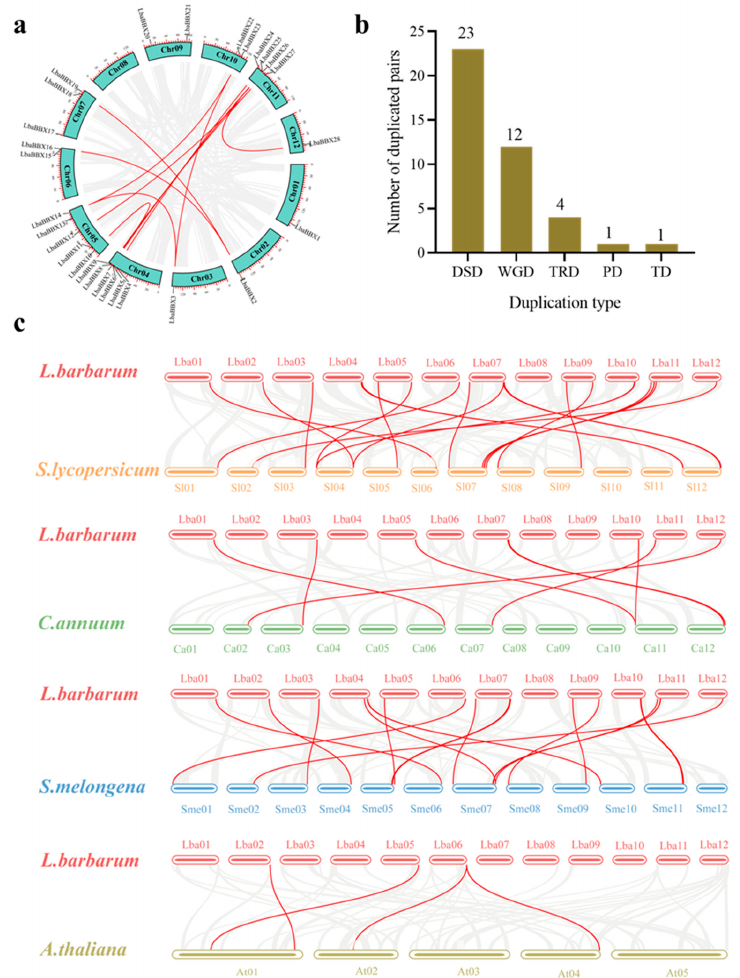
Figure 3. Chromosomal location and duplicated genes among LbaBBX genes. ( a ) Intraspecific col- linearity analysis. A total of 28 LbaBBX genes were mapped onto the chromosomes based on their physical location. The red lines indicate duplicated LbaBBX gene pairs. ( b ) Different models of gene duplication in LbaBBX family. The x -axis represents the duplication type. The y -axis represents the number of duplicated gene pairs. Whole genome duplication (WGD), tandem duplication (TD), proximal duplication (PD), transposed duplication (TRD), dispersed duplication (DSD). ( c ) Analysis of collinearity between two different species. The gray lines indicated duplicated blocks, while the red lines indicated the syntenic BBX gene pairs. Chromosome numbers are indicated above or below each chromosome.